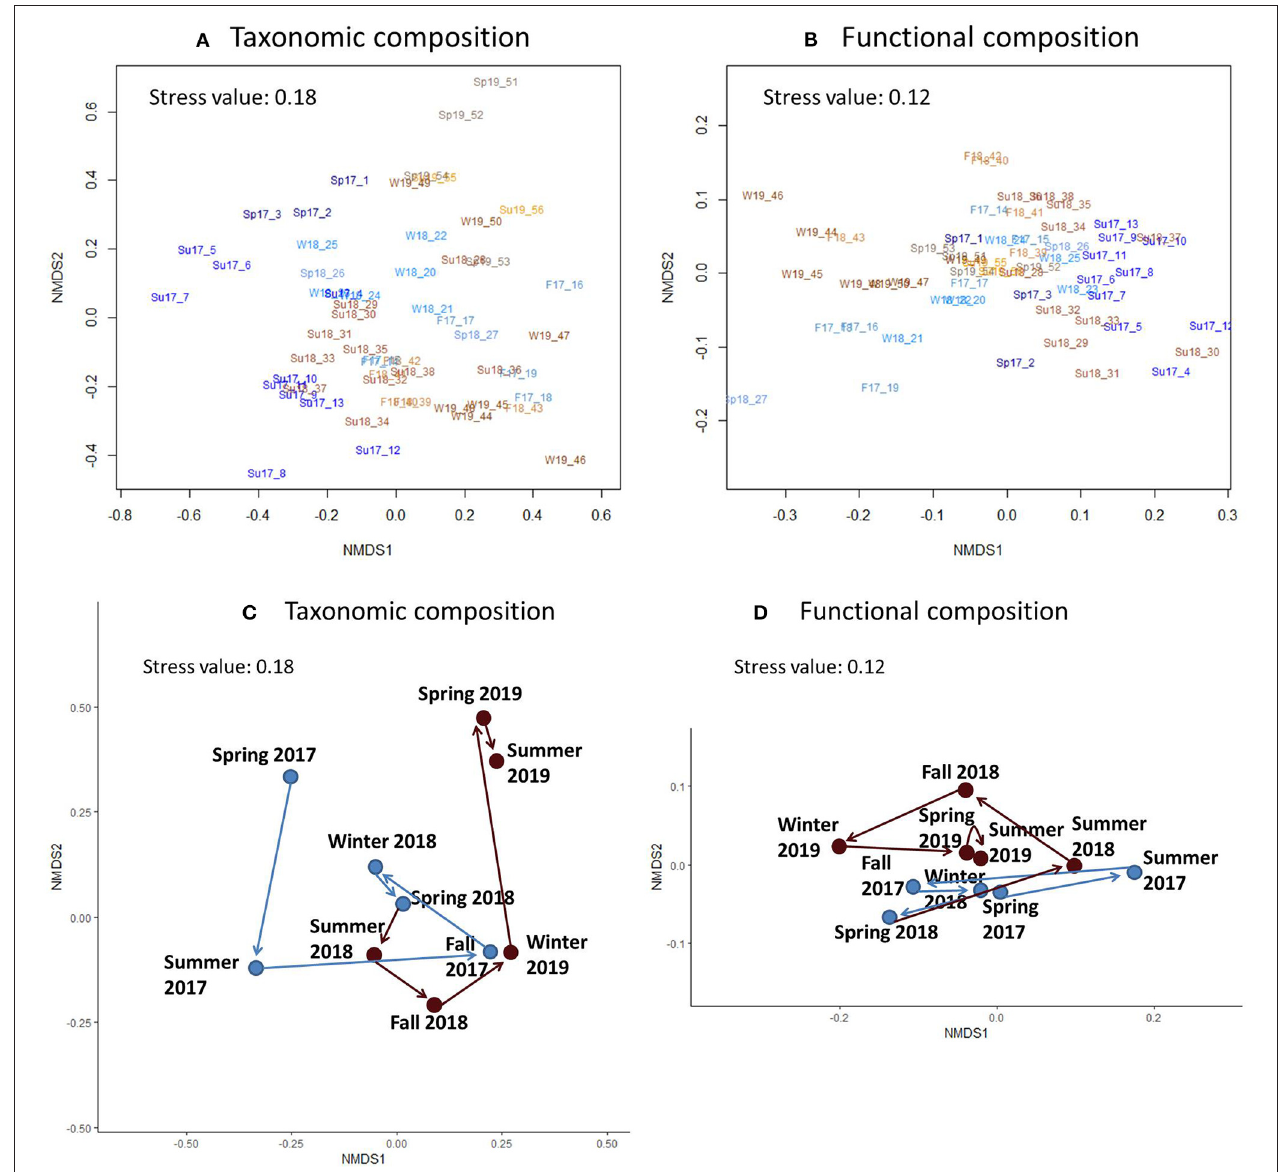
FIGURE 2 | Illustrations for Nonmetric Multidimensional Scaling (NMDS) for community composition. (A,C) Illustrate taxonomic composition, and (B,D) functional composition. (A,B) Illustrate all the sampling times. (C,D) Illustrate centroids calculated for the samples of each season, with arrows showing the directions of annual cycles in community composition. (C,D) Blue circles and arrows illustrate the cycle in community composition during the first sampling year, and the burgundy circles and arrows the cycle during the second sampling year. (A,B) Sp, spring; Su, summer; F, fall; W, winter; 17, year 2017; 18, year 2018; 19, year 2019. Numbers after the sampling year refer to the temporal order of